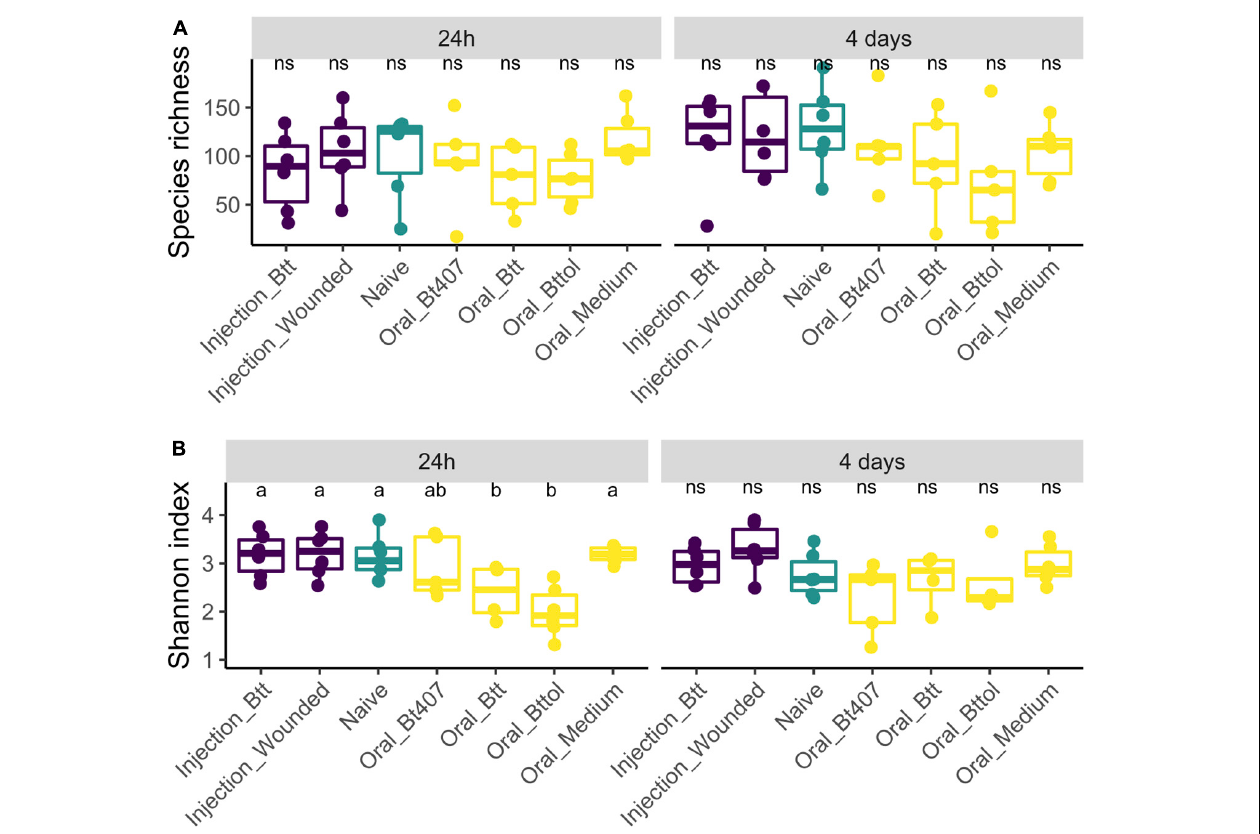
FIGURE 3 | Alpha biodiversity measures in relation to time points and treatment regimes. Each dot represents one replicate of 10 pooled larvae. The letters indicate the differences between the treatments after post hoc and p -value adjustment. (A) Observed species richness measure of experimental treatments 24 h and 4 days after priming shows no difference between the regimes (24 h: ANOVA, F = 0.95, Df = 6, p = 0.47; 4 days: ANOVA, F = 0.90, Df = 6, p = 0.50). (B) Shannon index measures of experimental treatments 24 h after priming shows a higher diversity in oral Btt and oral Bt tolworthi treatments (ANOVA Df = 6, F = 5.92, p = 0.003) and 4 days after priming showing no difference between the treatments (ANOVA, F = 2.30, Df = 6, p =